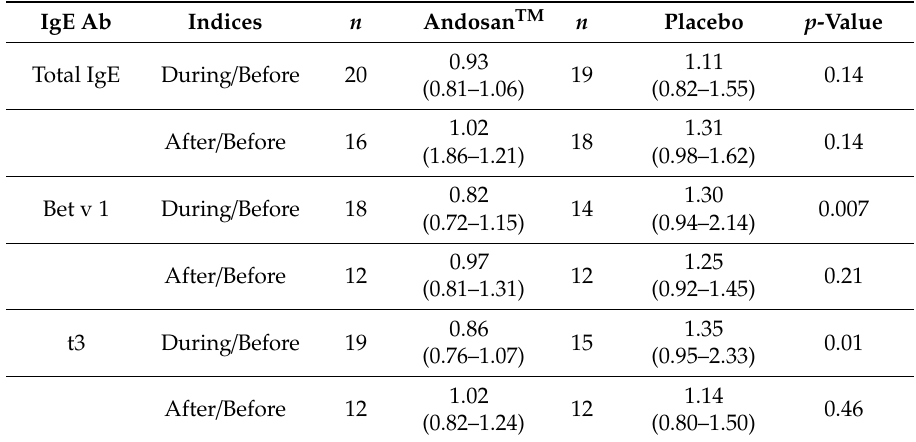
Table 3. Intervention data: IgE